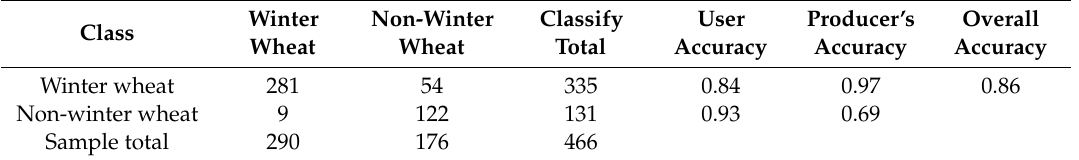
Table 2. Confusion matrix of land cover validation based on sample grids from high resolution satellite images from Google Earth and from the Google Earth Engine.